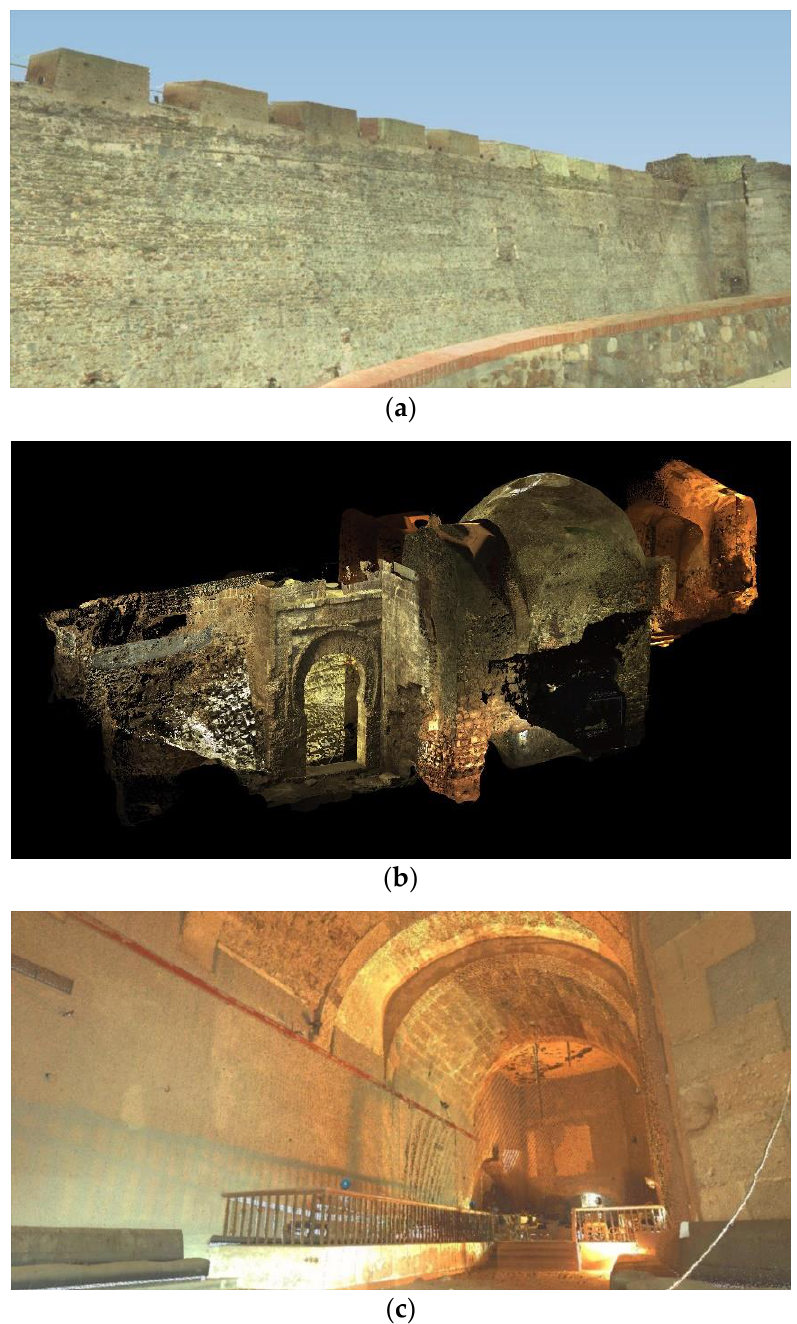
Figure 4. Images obtained from point-clouds. ( a ) Royal walls. ( b ) Detail of the inner distribution of the site. ( c ) Cave “El Candelero”.